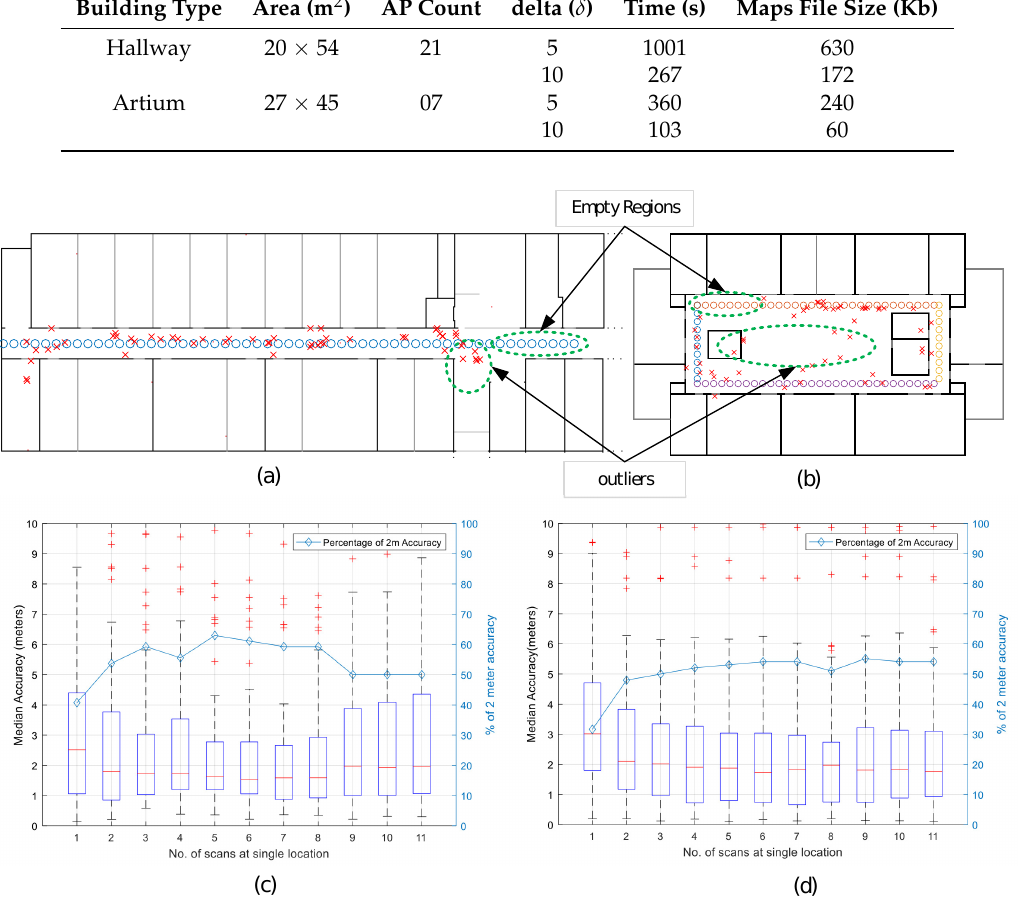
Figure 7. ( a ) ground truth reference points of the RSSI received from user “circles” from one end of the corridor to the other and localization points of the user “Xs” estimated by the system, along a straight path of the IT Building; and ( b ) actual reference points of the user and estimated localized points around the open area of the RIC Building hallway; ( c , d ) median accuracy in meters and percentage less than 2 m accuracy with respect to number of scans taken at a reference point for the IT and RIC Buildings,